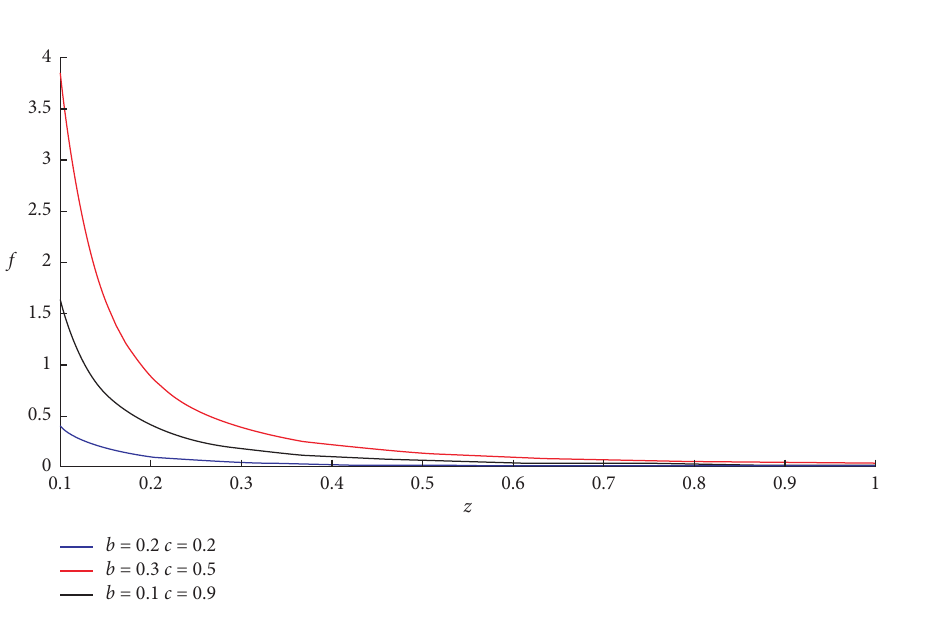
Figure 2: The graph of PDF for equation (23); we take three cases of the values of the parameters: first case b � c � 0 . 2, second case b � 0 . 3 and c � 0 . 5, and final case b � 0 . 1 and c � 0 .